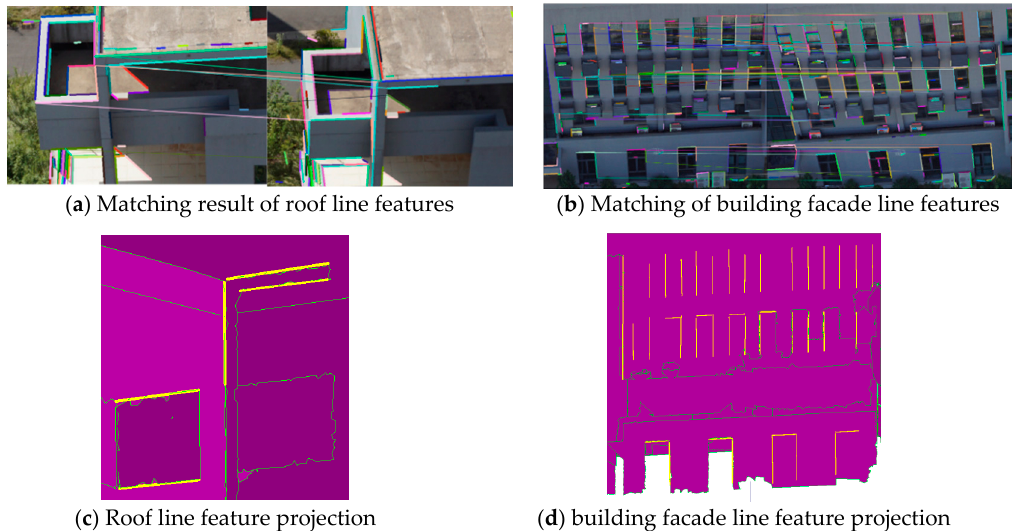
Figure 12. Results of line feature matching and projection the forward intersected lines to corresponding segmented